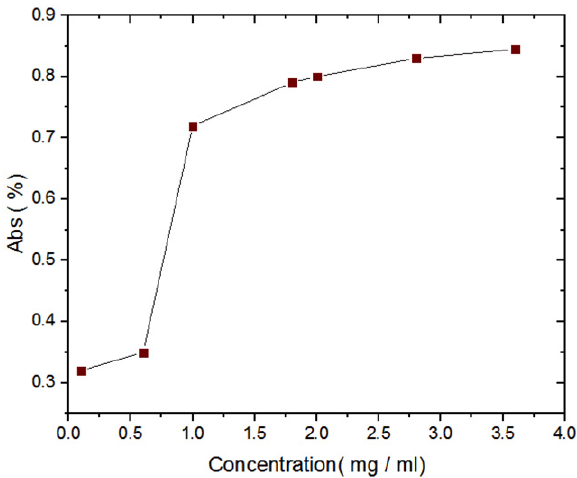
Figure 8. The effect of DOX concentration on adsorption efficien- cy of Gr Mn / GO / CS / A. sativum / Que